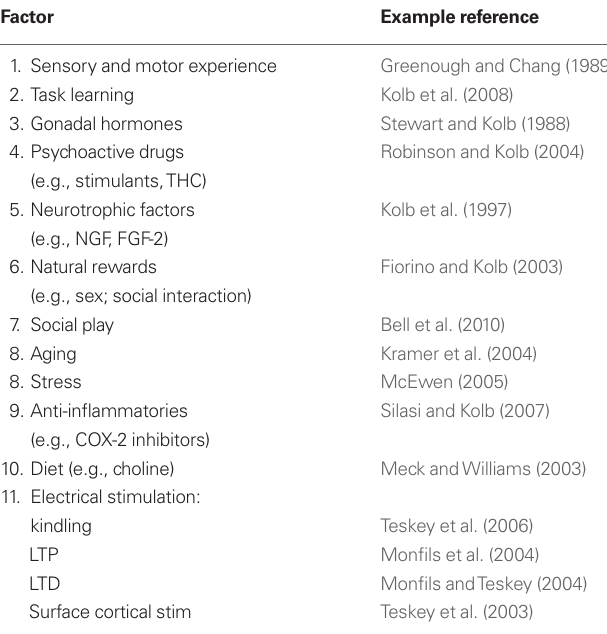
Table 1 | Factors affecting the synaptic organization of the normal